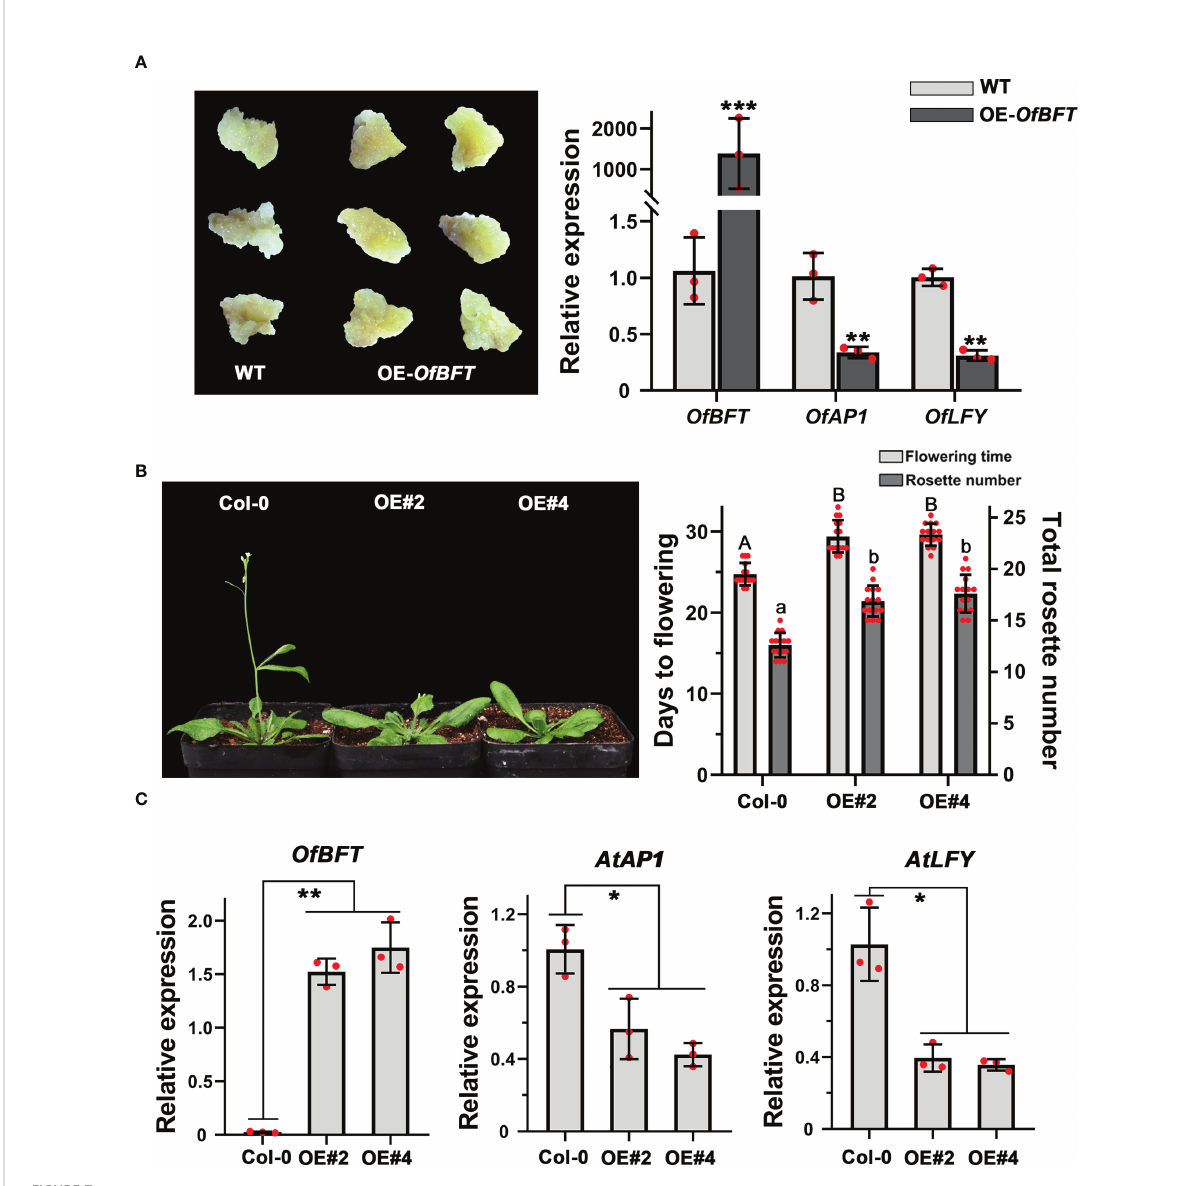
FIGURE 7 OfBFT functioned as a fl owering suppressor in both O. fragrans and Arabidopsis . (A) The expression levels of fl owering-related genes in overexpression ‘ Sijigui ’ callus. Data were the means ±SD, n = 3, Student ’ s t test, ** p < 0.01 and *** p < 0.001. (B) Phenotypic analyses of transgenic Arabidopsis plants overexpressing OfBFT . Uppercase letters represent signi fi cance of fl owering time compared with mock-treated control. Lowercase letters represent signi fi cance of rosette number compared with mock-treated control. Means ± SD, n = 3, * p < 0.05, ** p < 0.01. (C) The expression levels of fl owering-related genes in transgenicplants. Means ±SD, n = 3. * p < 0.05, ** p <